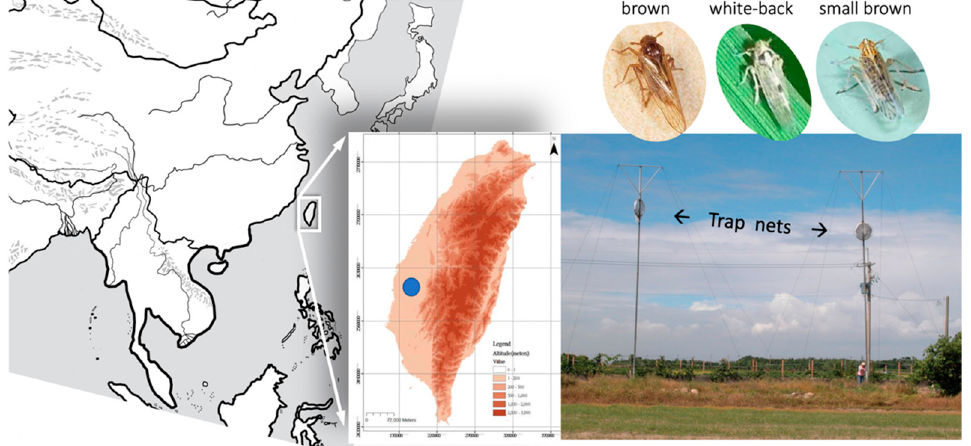
Figure 1. Map of Taiwan, its topography, and the location of the tow-net traps in Southwest Taiwan (blue dot). Pictures of the two tow-net traps and the three species of rice planthoppers are shown on the right.